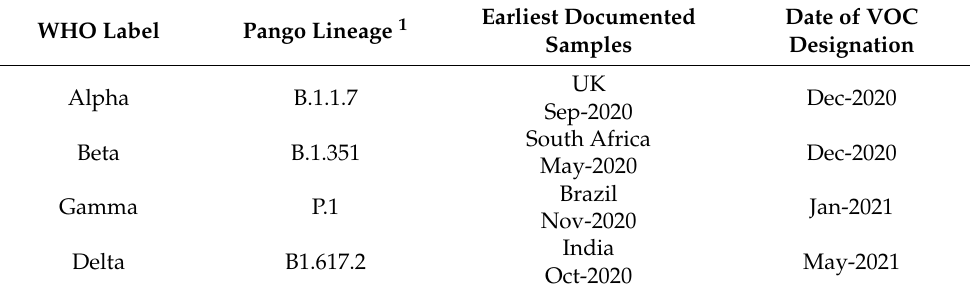
Table 3. SARS-CoV-2 Variants of Concern (VOC) as defined by WHO (as of 22 October 2021) [62]. WHO